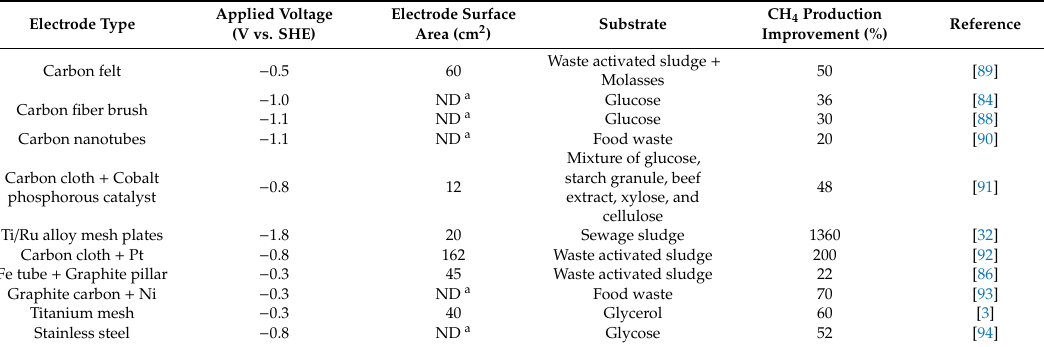
Table 3. Impact of various voltages’ application upon CH 4